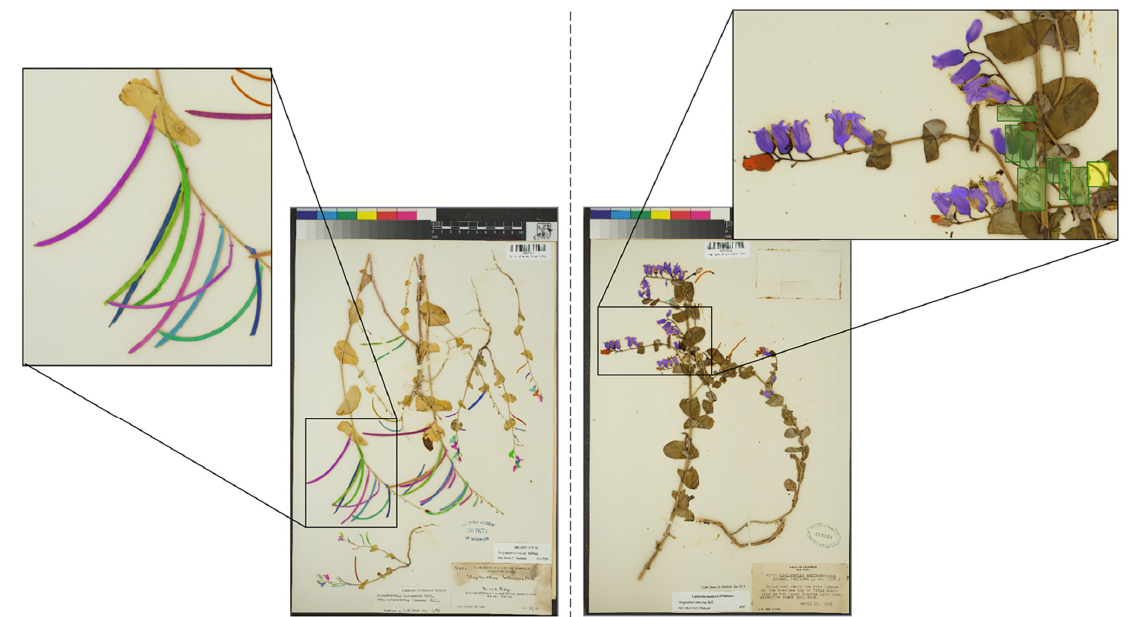
Figure 3. Examples of manually produced masks used to train the recognition model. In the specimen on the left, several mature fruits overlap, so only the structures in the foreground were annotated in this case, resulting in the exclusion of background structures from the segmentation in that part of the image. The specimen on the right displays examples of predicted masks (buds in red, flowers in purple, immature fruits in orange, mature fruits in blue) on a test specimen. The organs that were not detected (flowers in green rectangles and immature fruit in a yellow rectangle) are either very largely degraded, or partially hidden behind stems or leaf lamina.